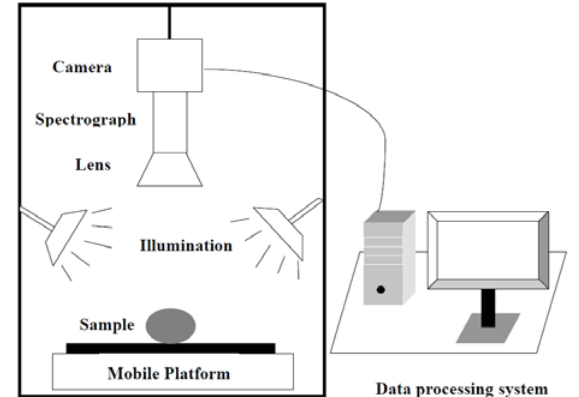
Figure 1. Schematic diagram of hyperspectral imaging